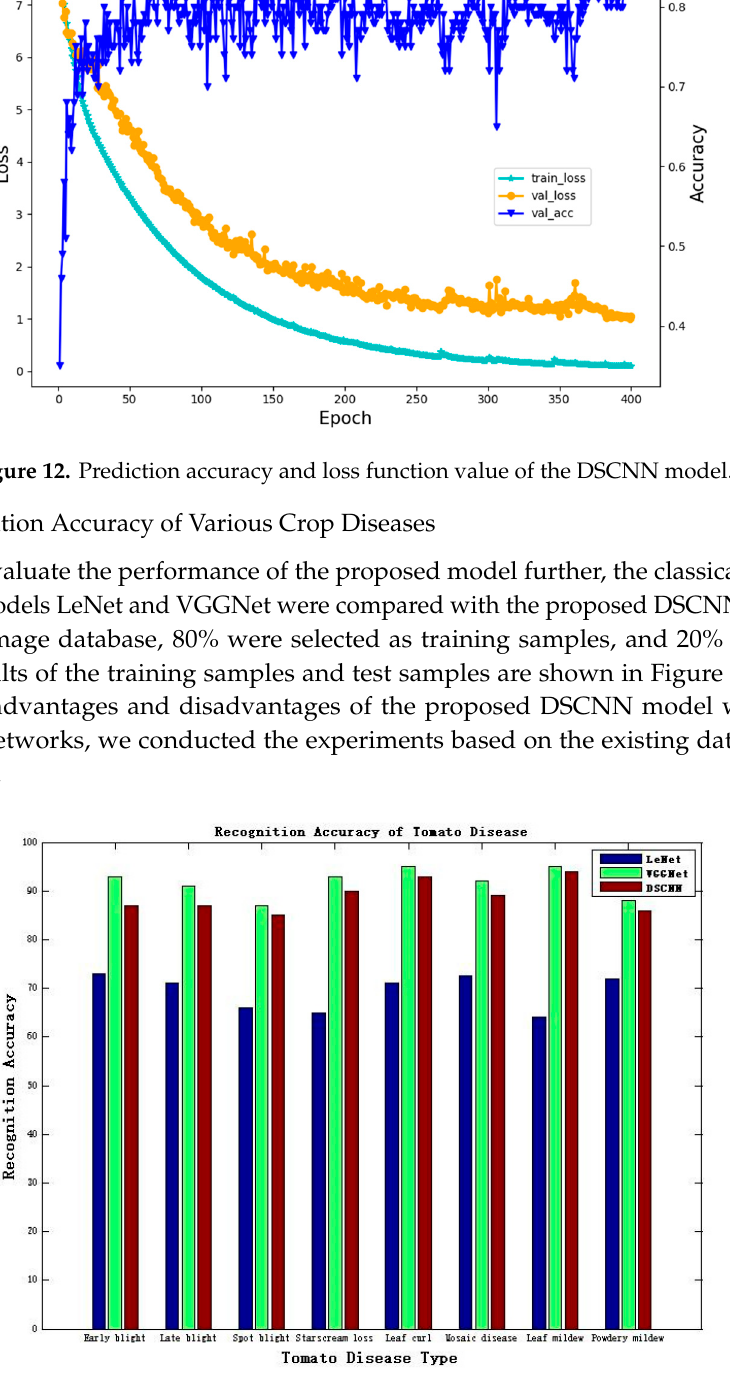
Figure 13. Comparison of accuracy of tomato diseases between LeNet, VGGNet, and DSCNN.